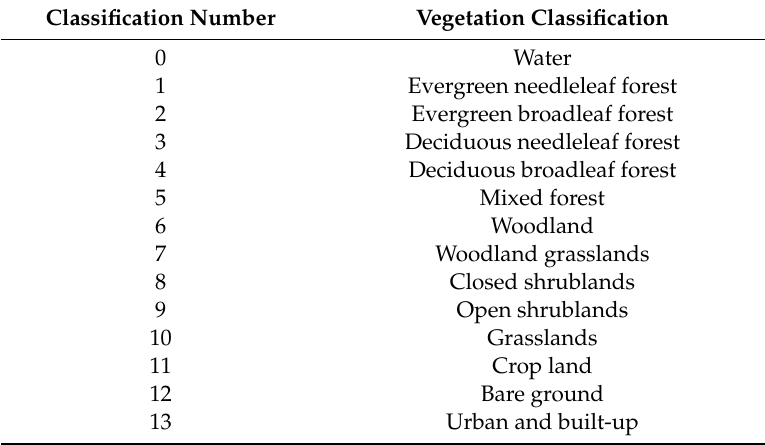
Table 1. Description of global land cover types developed by the University of